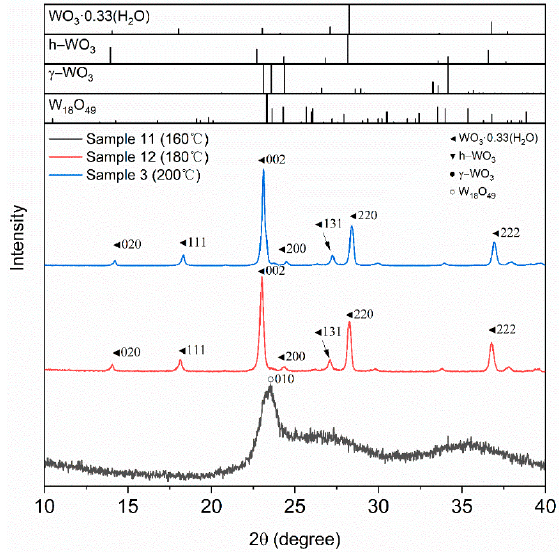
Figure 7. XRD spectra of samples that are synthesized at temperature of 160 °C (sample 11), 180 °C (sample 12), and 200 °C (sample 3), each for 12 h. The top inset is the standard reference di ff raction pa tt erns of W 18 O 49 (JCPDS no. 36-0101), h-WO 3 (JCPDS no. 75-2187), WO 3 ·0.33(H 2 O) (JCPDS no. 87- 1203), and γ -WO 3 (JCPDS no. 32-1295).